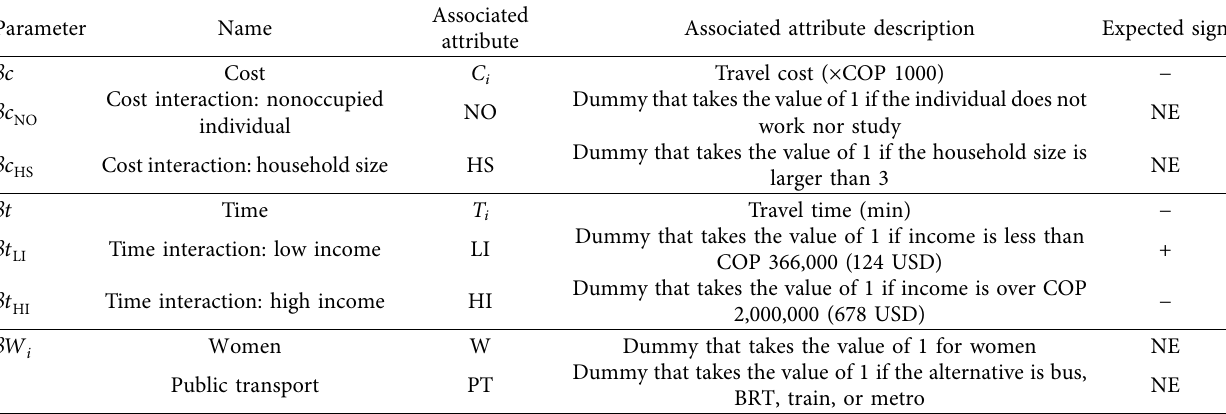
Table 4: Description of parameters and attributes in the utility